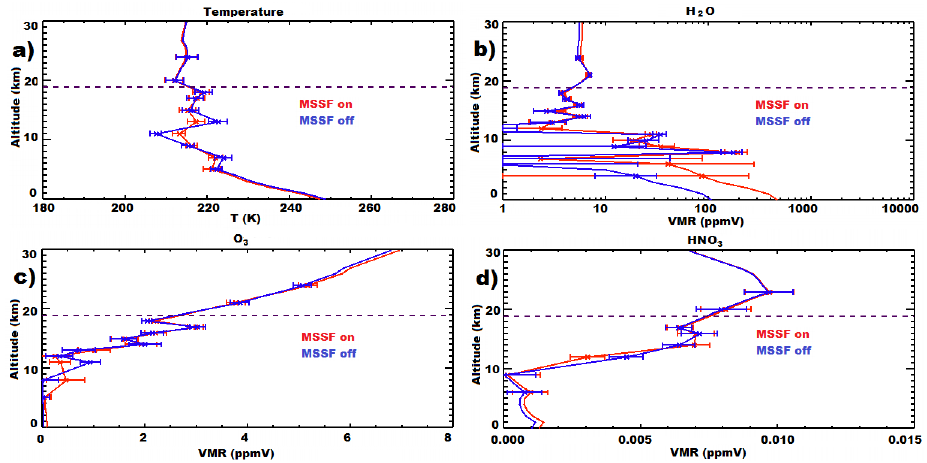
Fig. 19. (a) Temperature, (b) H 2 O, (c) O 3 and (d) HNO 3 retrieved from MARSCHALS scan 51 using (red) or excluding (blue) the MSSF module.